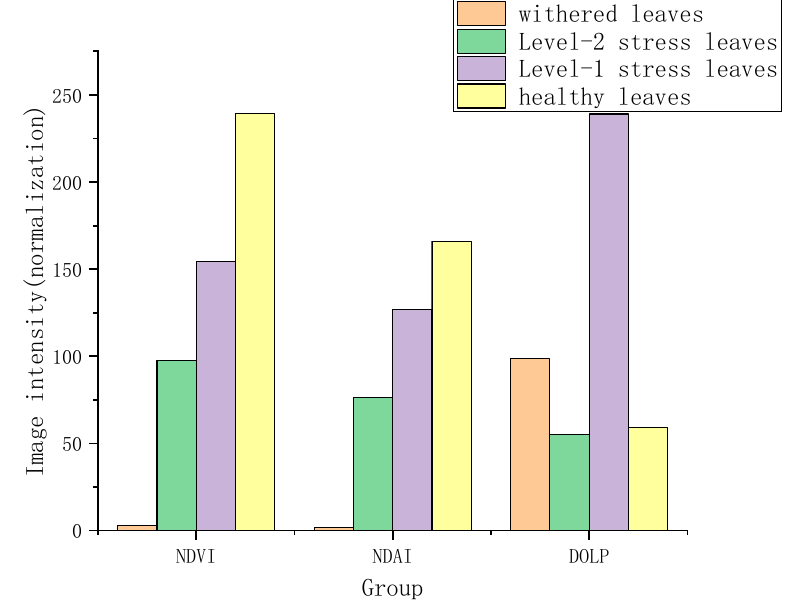
Figure 14. The NDVI, NPSDI and DoLP histograms of the plant in the four health status regions.